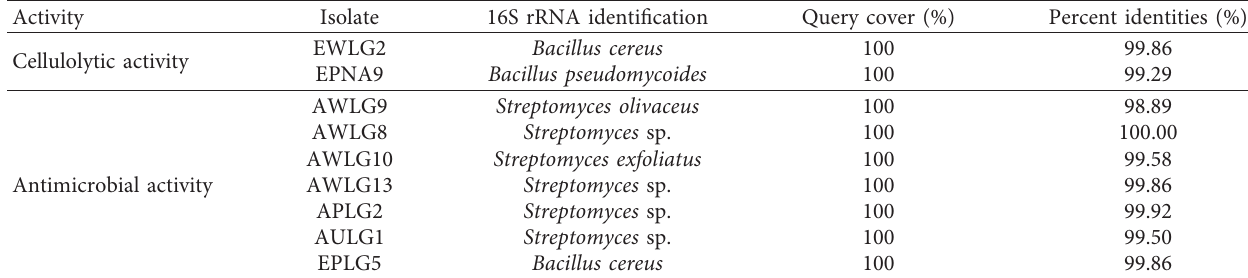
Table 2: Molecular identification of the isolates with cellulolytic and/or antimicrobial activity using 16S rRNA sequences. Activity